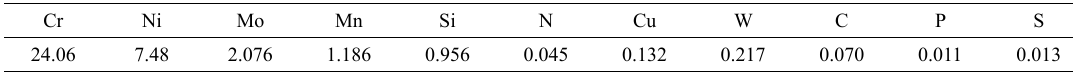
Table 1. Chemical composition (wt.%) of the DSS investigated. Cr Ni